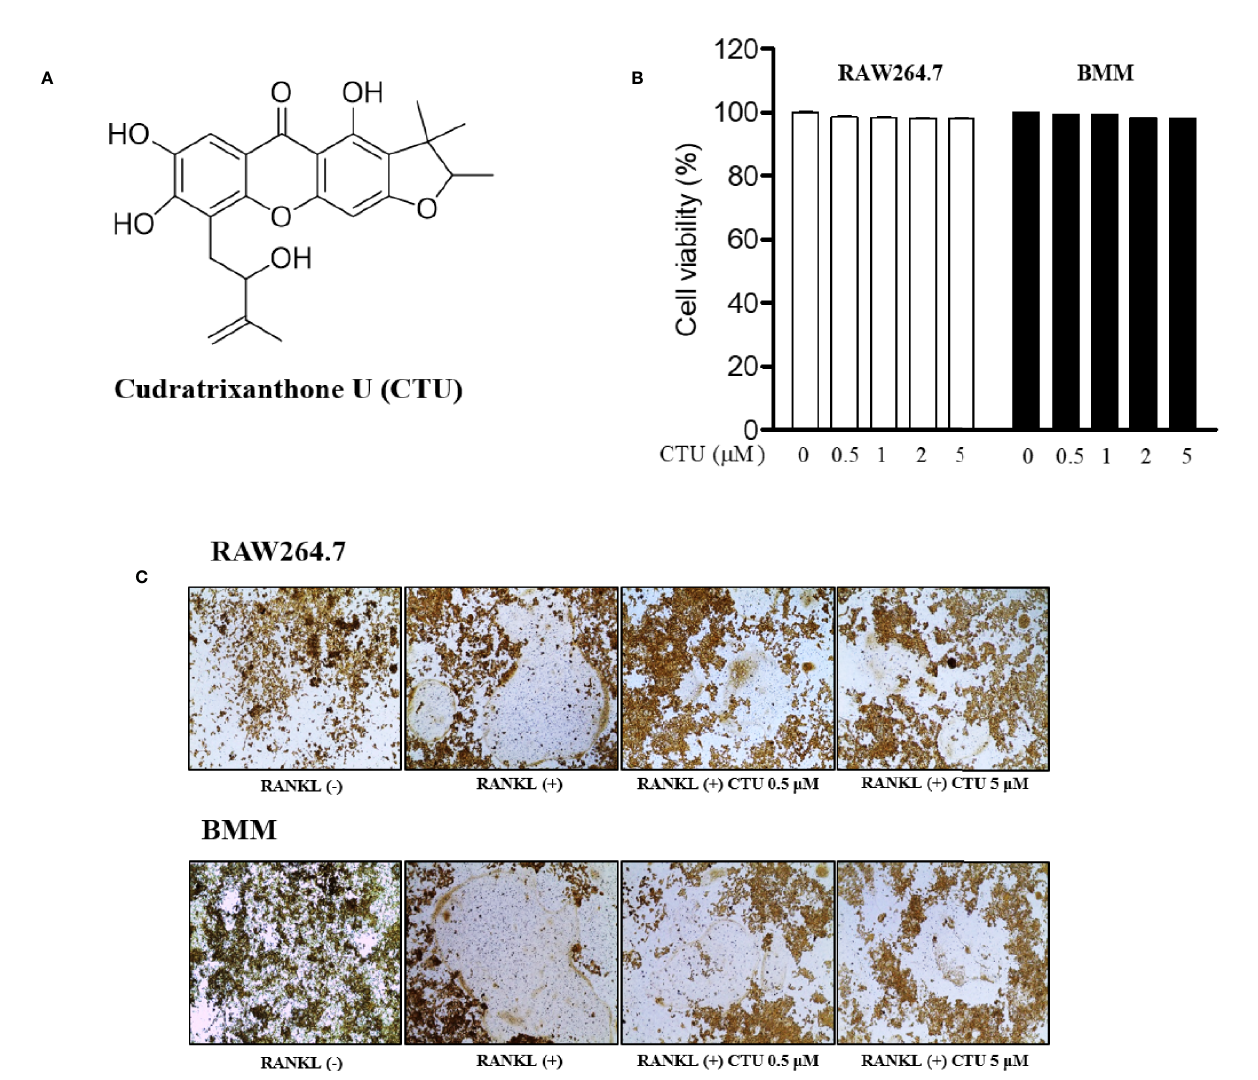
FIGURE 1 | The viability of CTU in RAW264.7 and BMM cells. The chemical structure of cudratrixanthone U (CTU) (A) . Effect of CTU on cell viability measured by MTT assay. RAW 264.7 and BMM cells were incubated with various concentrations of CTU for 5 days (B) . The effect of CTU in differentiated osteoclasts on morphology (C)